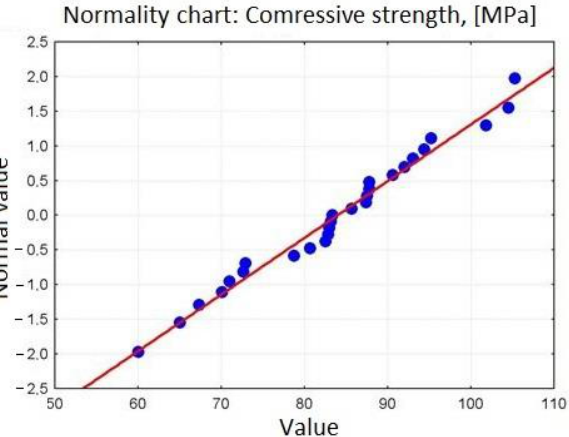
Figure 4. Graph of distribution normality for variables compressive strength.